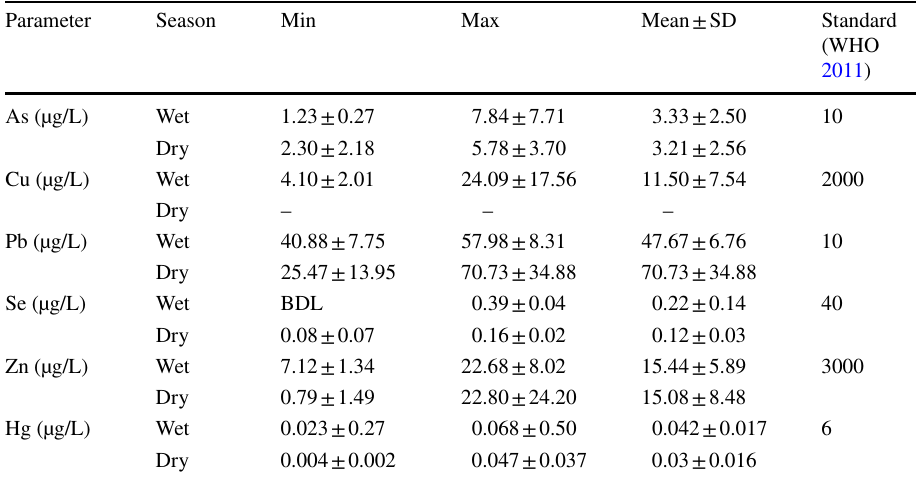
Table 2 Heavy metals concentration of water samples during the wet and dry seasons